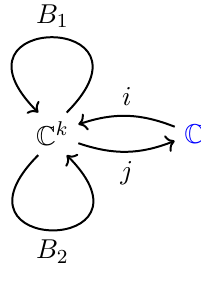
Figure 9. The ADHM